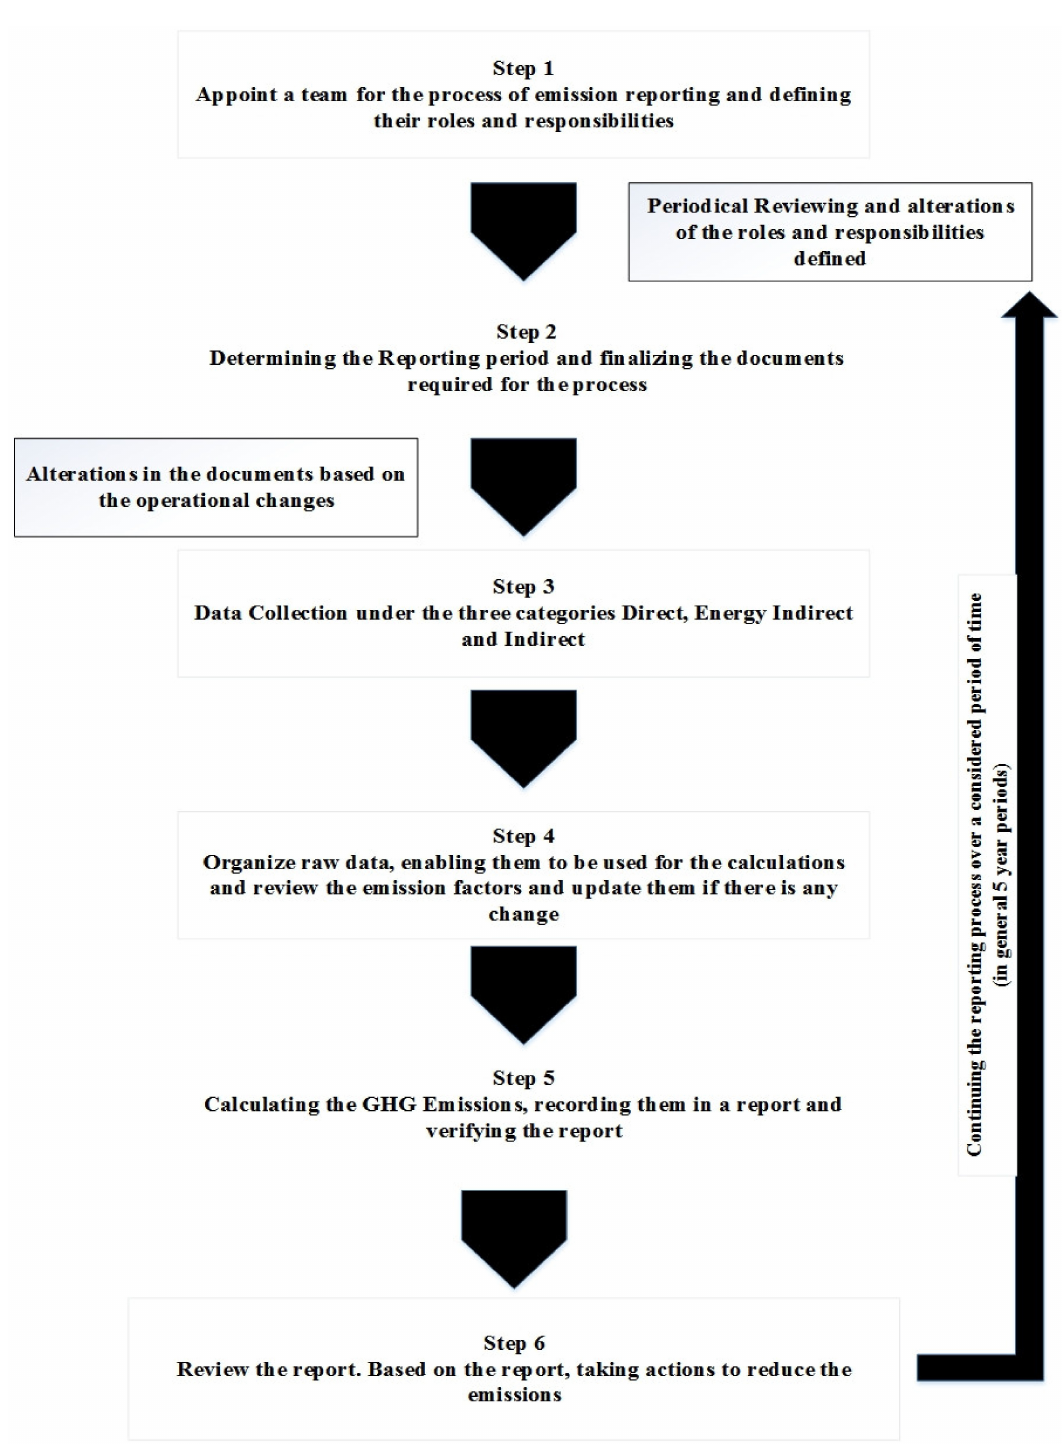
Figure 2. General procedure followed to quantify hotel carbon